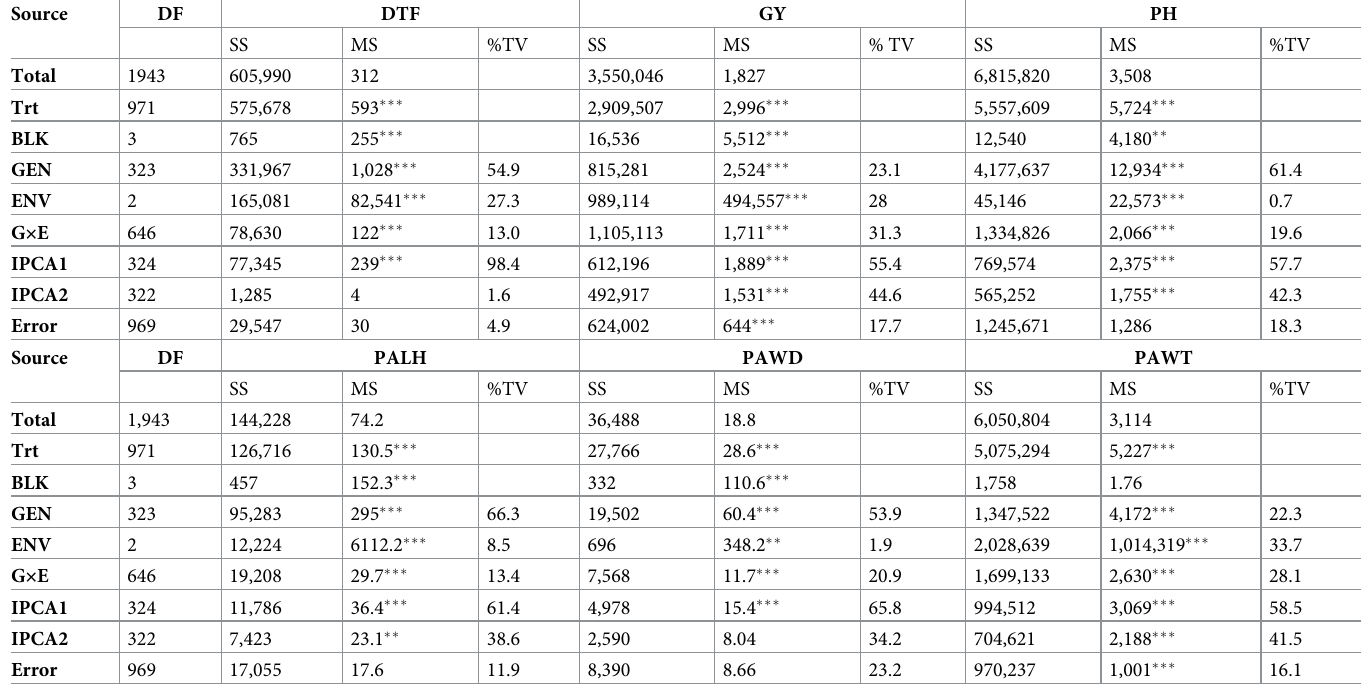
Table 3. AMMI ANOVA for grain yield and related traits of 324 sorghum genotypes across three